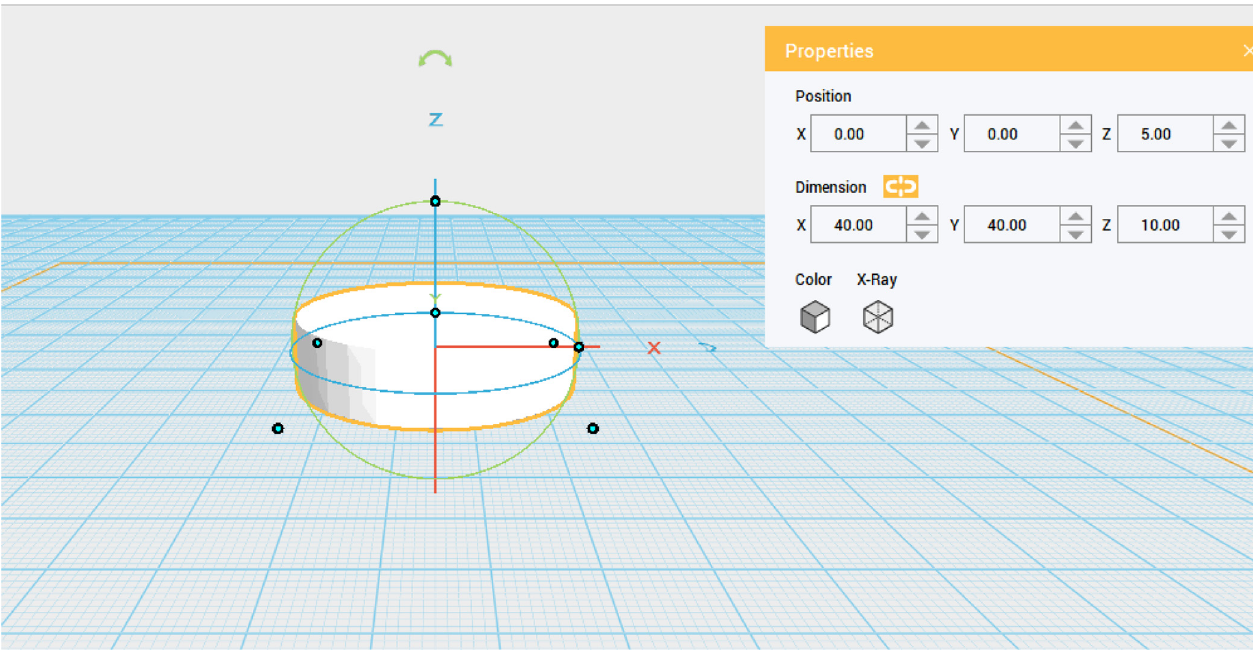
Fig. 1. Fabricated workpiece.